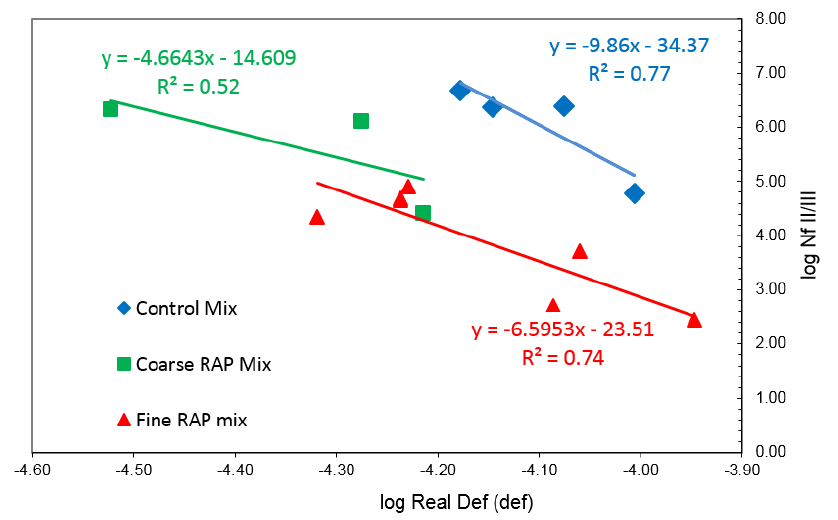
Figure 15. Wöhler Curve.